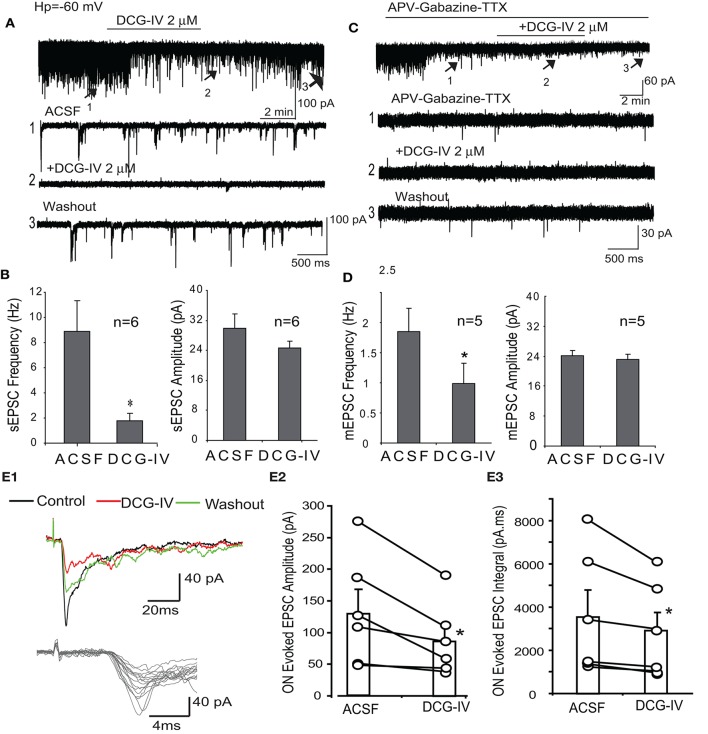
DCG-IV decreases spontaneous and ON-evoked EPSCs in PG cells. (A) PG cell voltage clamp recordings (Vhold = −60 mV) shows that DCG-IV (2 μM) suppresses sEPSCs. Lower traces show faster time scale records at indicated time points. (B) Group data showing that DCG-IV significantly decreases sEPSC frequency but not amplitude; *p < 0.05 compared to control. (C) mEPSCs recorded in the presence of APV-gabazine-TTX are suppressed by DCG-IV, as also shown in lower, faster time scale traces. (D) Group data showing DCG-IV significantly decreases mEPSC frequency but not amplitude; *p < 0.05, compared to control. (E1) ON-evoked polysynaptic EPSCs in a PG cell were suppressed by DCG-IV (2 μM). Lower faster timescale traces show jitter in EPSC onset latency. (E2,3) Group data (n = 6 PG cells) showing the effect of DCG-IV on EPSC peak amplitude (E2) and integral (E3). *p < 0.05 vs. control, paired t-test.